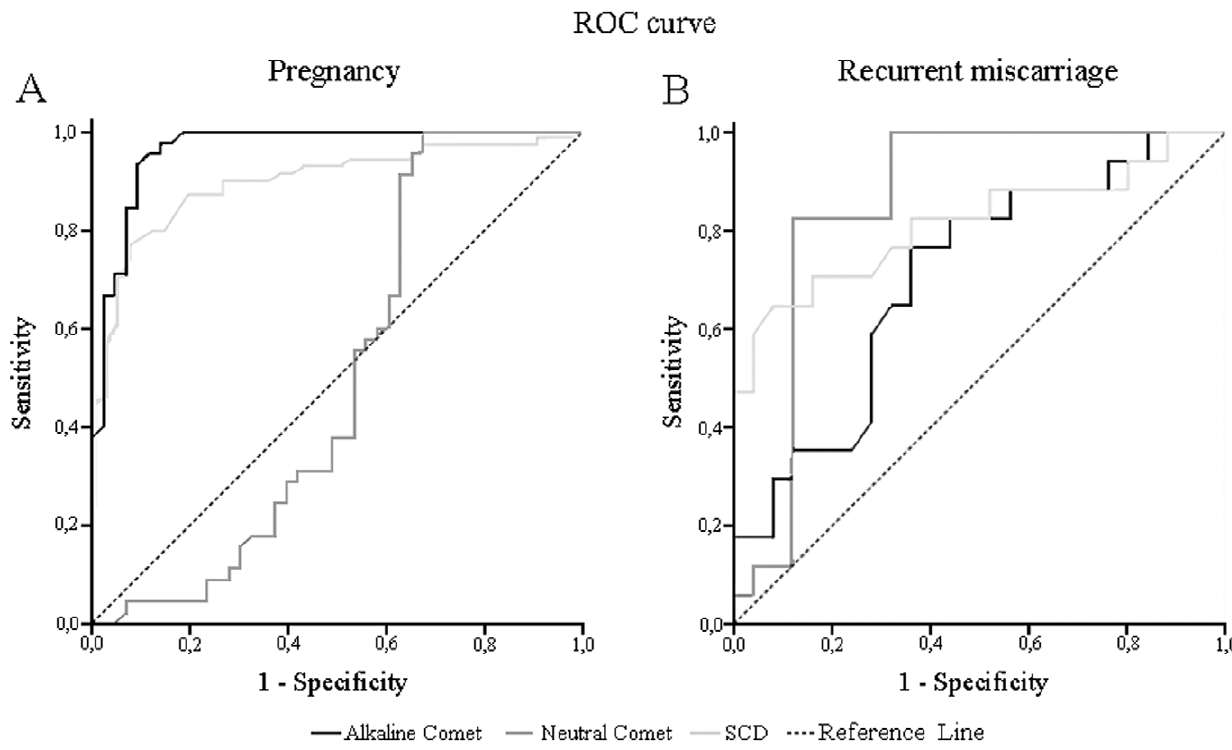
Figure 3. ROC curves analysis for alkaline Comet, neutral Comet and SCD attending: Pregnancy without miscarriage (A), and recurrent miscarriage (B).